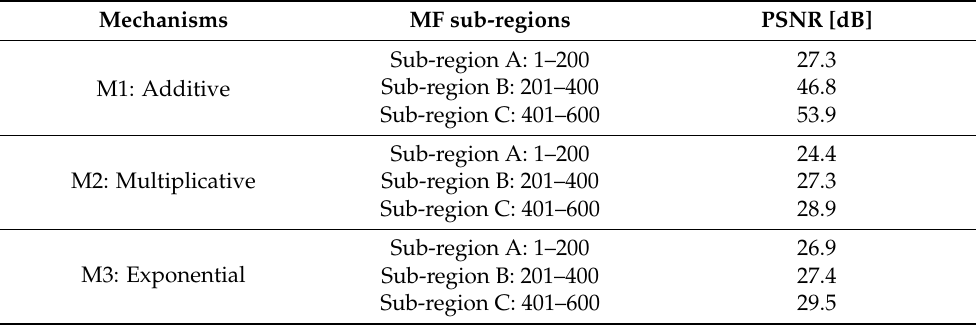
Table 2. PSNR performance of the proposed display-to-camera (D2C) model featuring data embed- ding in different areas of the mid-frequency (MF)